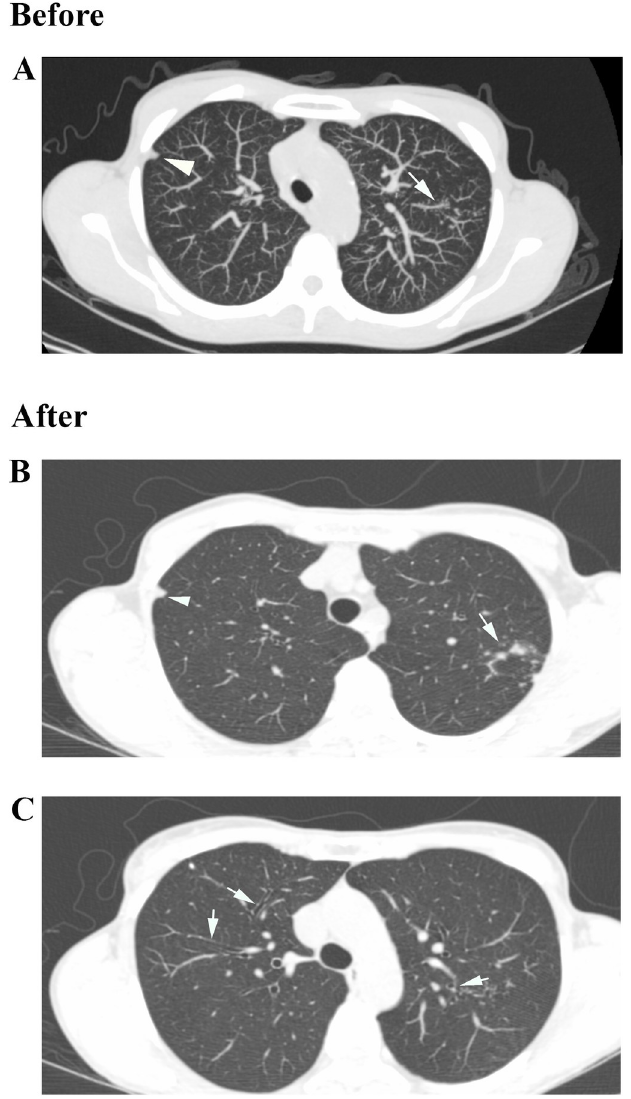
Fig 3. Chest HRCT of a 47-year-old woman (2014–2019). (A) Before: Pleural thickening (Arrowhead) and Centrilobular Nodules in a Tree in Bud shape (Arrow); (B) After: Evolution of Tree in Bud lesion (Arrow) and Pleural thickening (Arrowhead); (C) After: Bronchiectasis